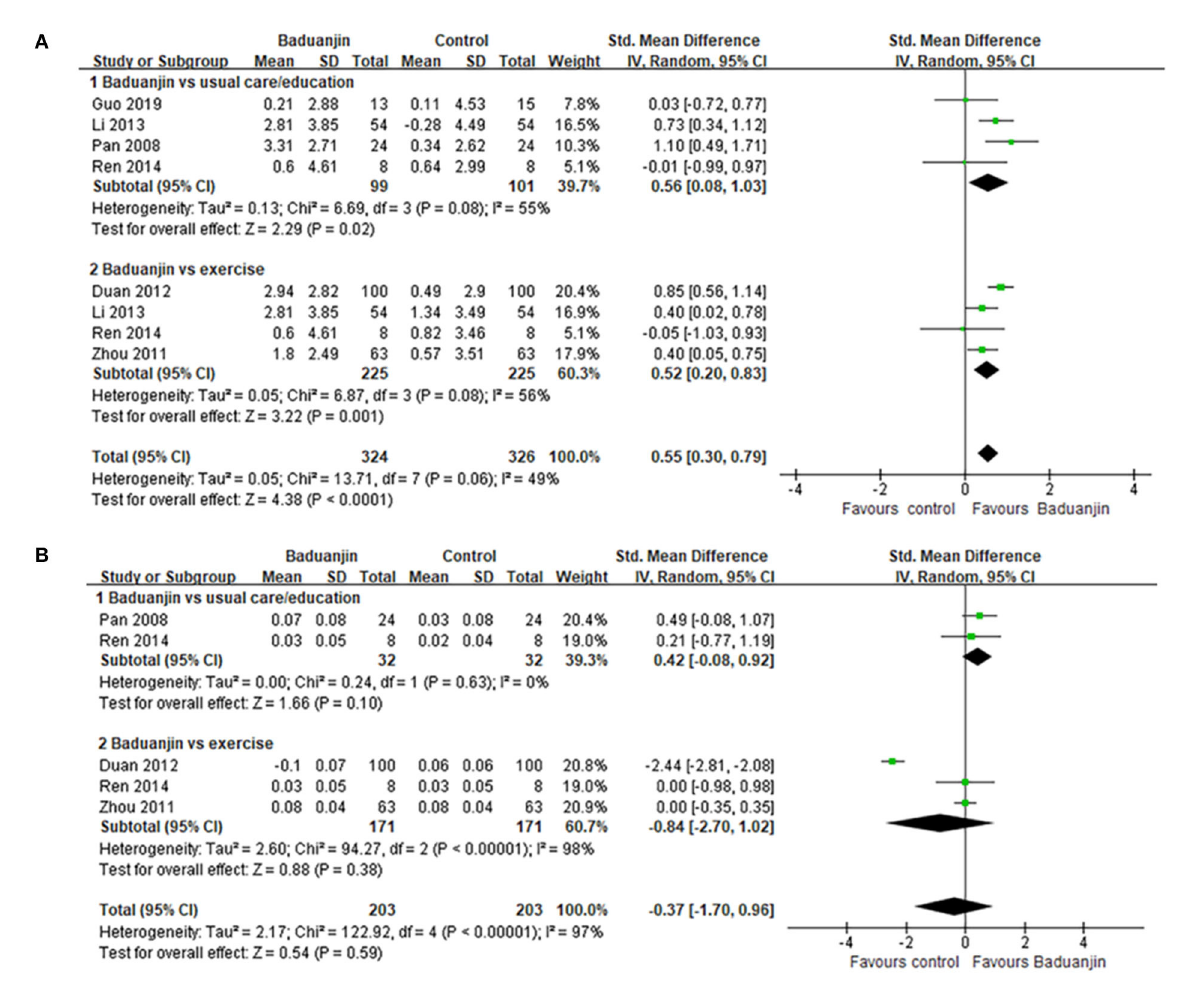
FIGURE5 Forest plot of the effects of Baduanjin exercises on (A) body mass index and (B) wait-hip